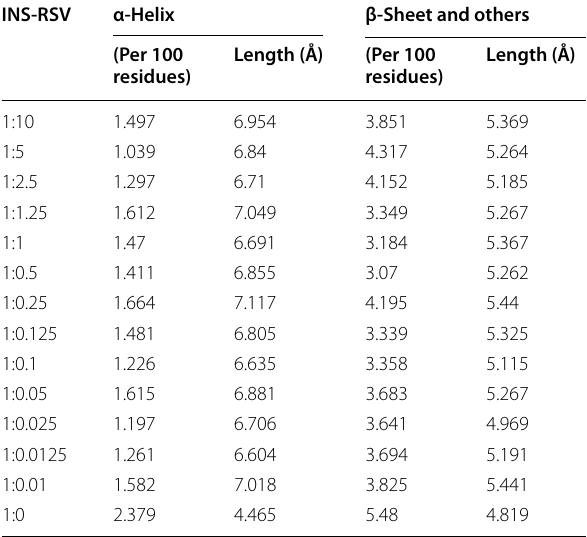
Table 3 The amount and length of secondary structure in INS‑ RSV solution INS-RSV α-Helix β-Sheet and